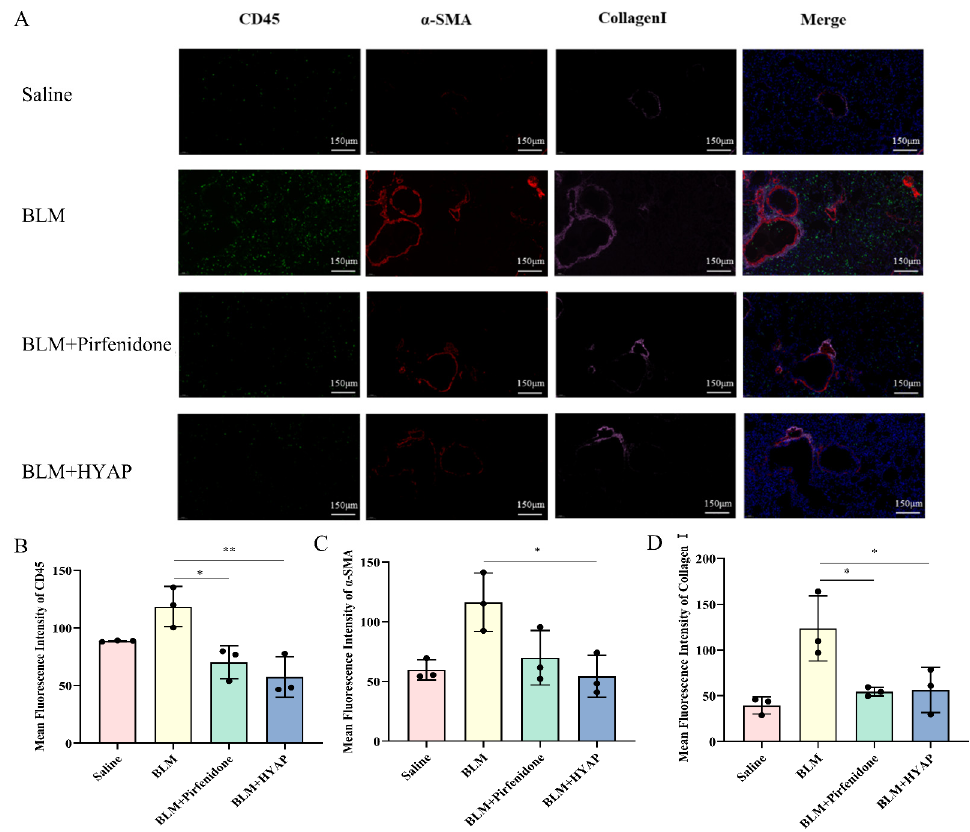
Figure 4. Immunofluorescence staining showing inflammatory infiltrates and fibroblast activation. ( A ) Immunofluorescence assay for CD45 (green), α -SMA (red), and collagen I (pink) expression in lungs ( n = 3). Scale bar: 150 µ m. ( B – D ) Expression of CD45, α -SMA, and collagen I in lungs after different treatments ( n = 3). Fluorescence intensity was analyzed with Image J software. ** p < 0.01, * p <